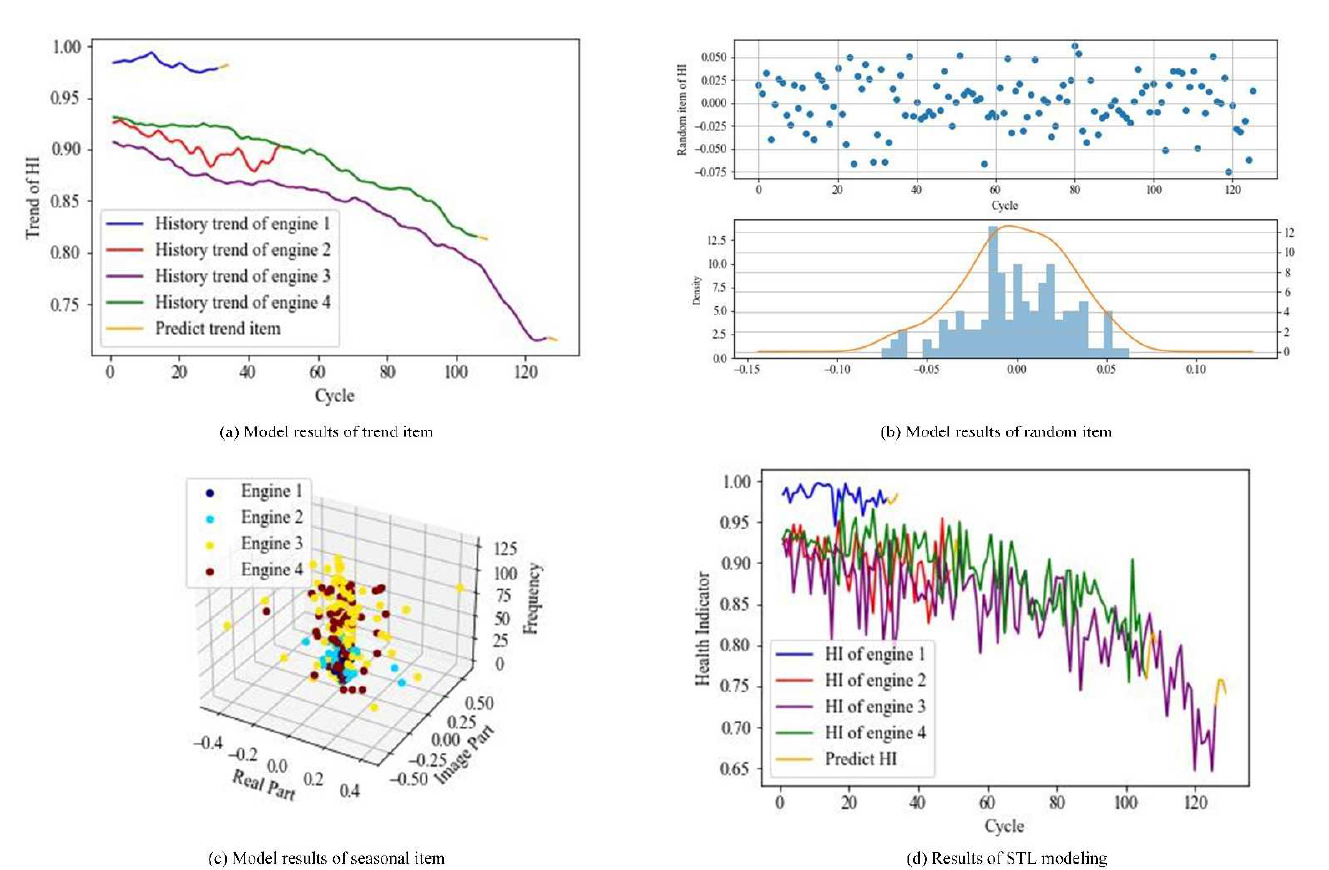
Figure 13. STL decomposition modeling result.